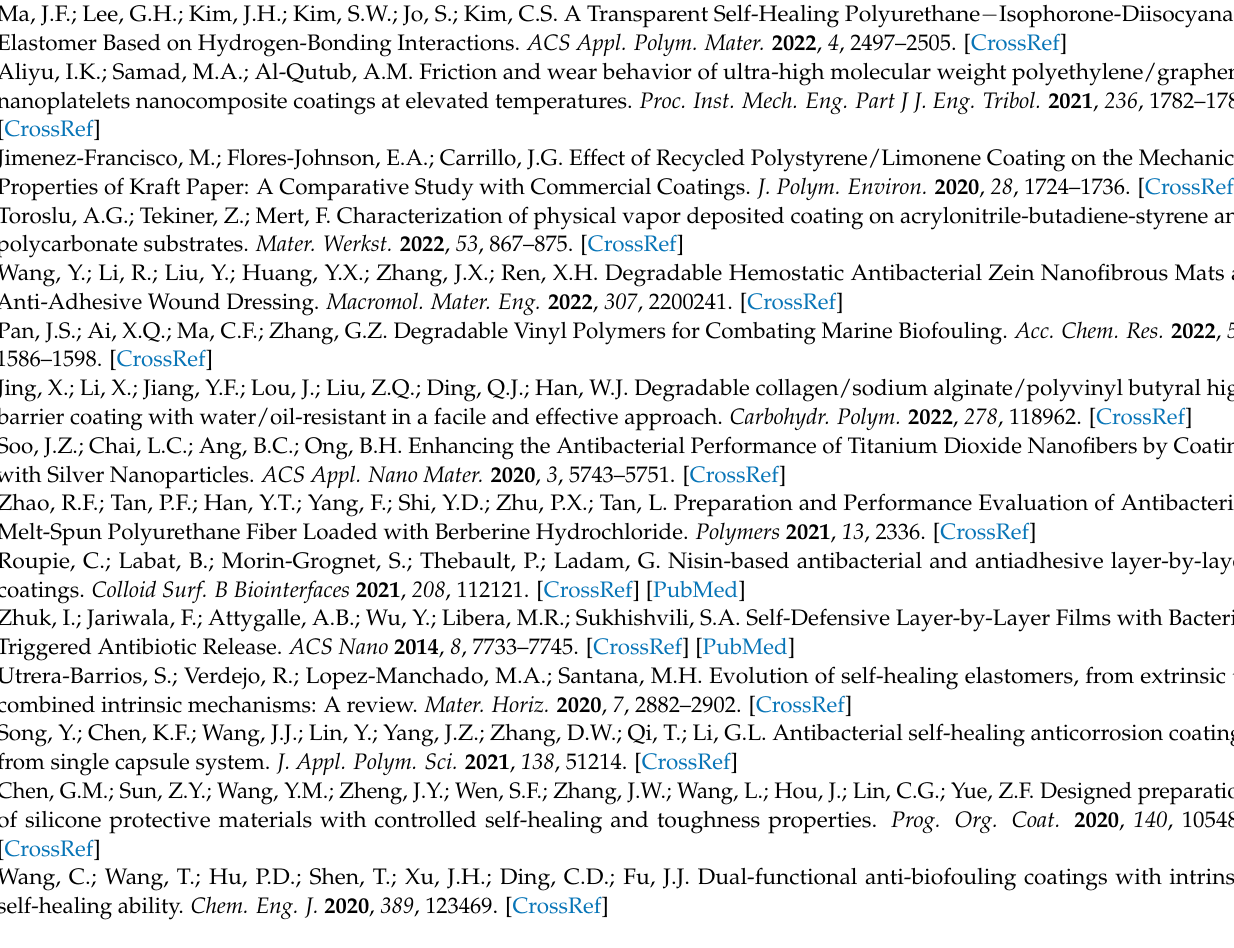
Table S1: Thermal degradation temperatures (Tpeak, ◦ C) and weight loss ( ∆ W, %) of GE coating and GE-NPs10%